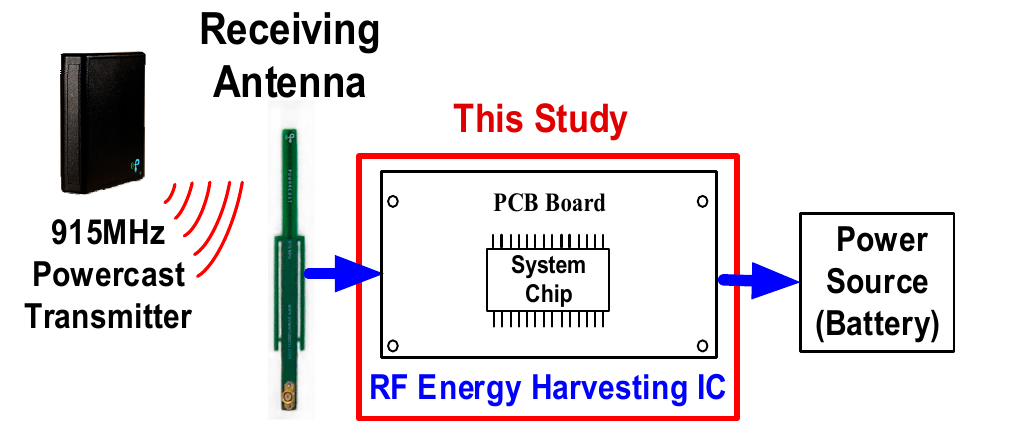
Figure 1. Proposed RF-energy-harvesting system.